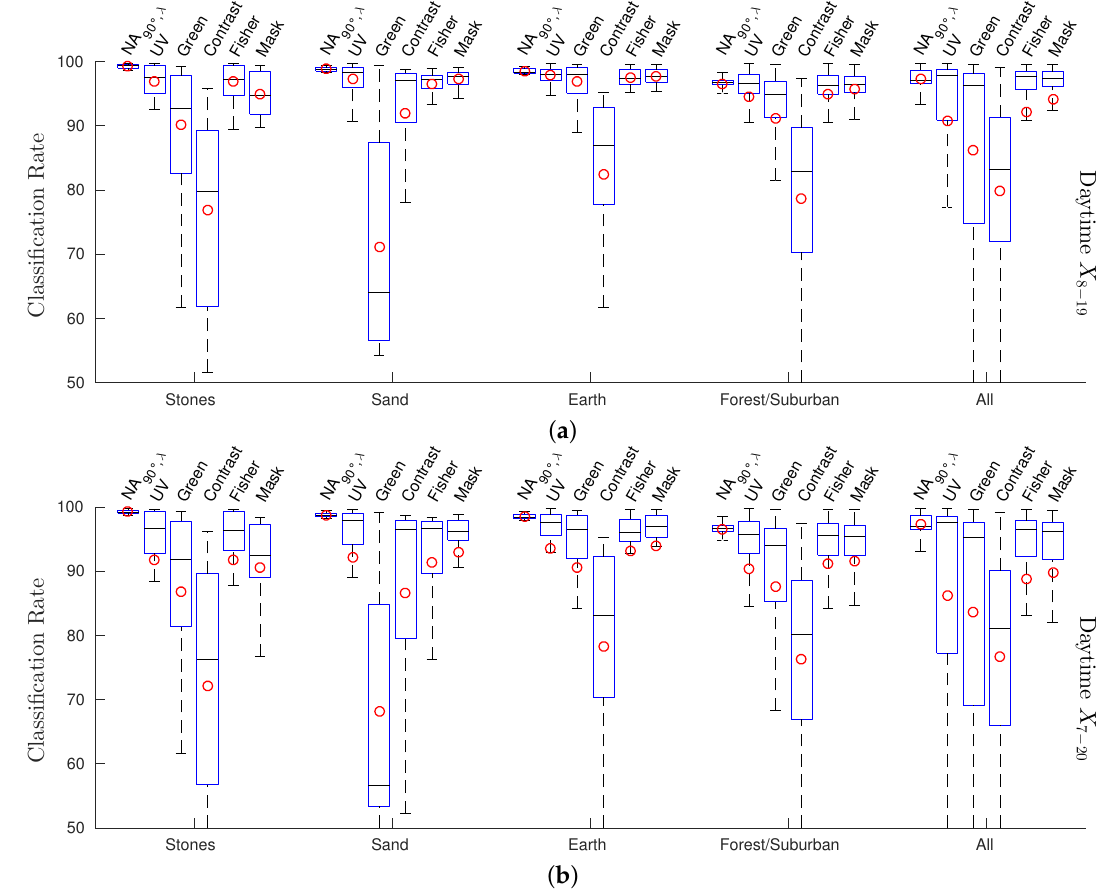
Figure 11. Box plots of the classification rates for the local separation technique NA 90 ◦ , α and all global separation techniques (UV/green/contrast/Fisher/mask). As for the results presented in Table 1, the global separation techniques were trained on samples drawn from the specified databases, but in contrast, this evaluation uses single HDR image pairs (e.g., as captured by a mobile robot) as test data. The numbers of HDR image pairs classified in each box plot are for ( a ) X 8–19 and ( b ) X 7–20 : stones, sand, earth: n = 132/156; forest/suburban: n = 924/1092; all: n = 1320/1560. The box plots show the distribution of the classification rates for all separation techniques and databases. Each plot shows the mean (red circle), median (black line), the 25th and 75th percentiles (blue box) and a coverage of 3 σ ˆ = 97.7% (black dashed lines). For better readability, outliers are not